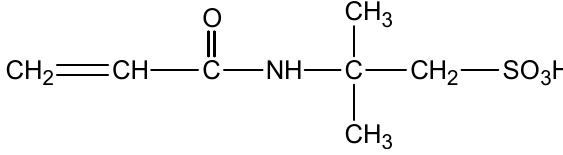
Figure 1. Molecular structure of AMPS.